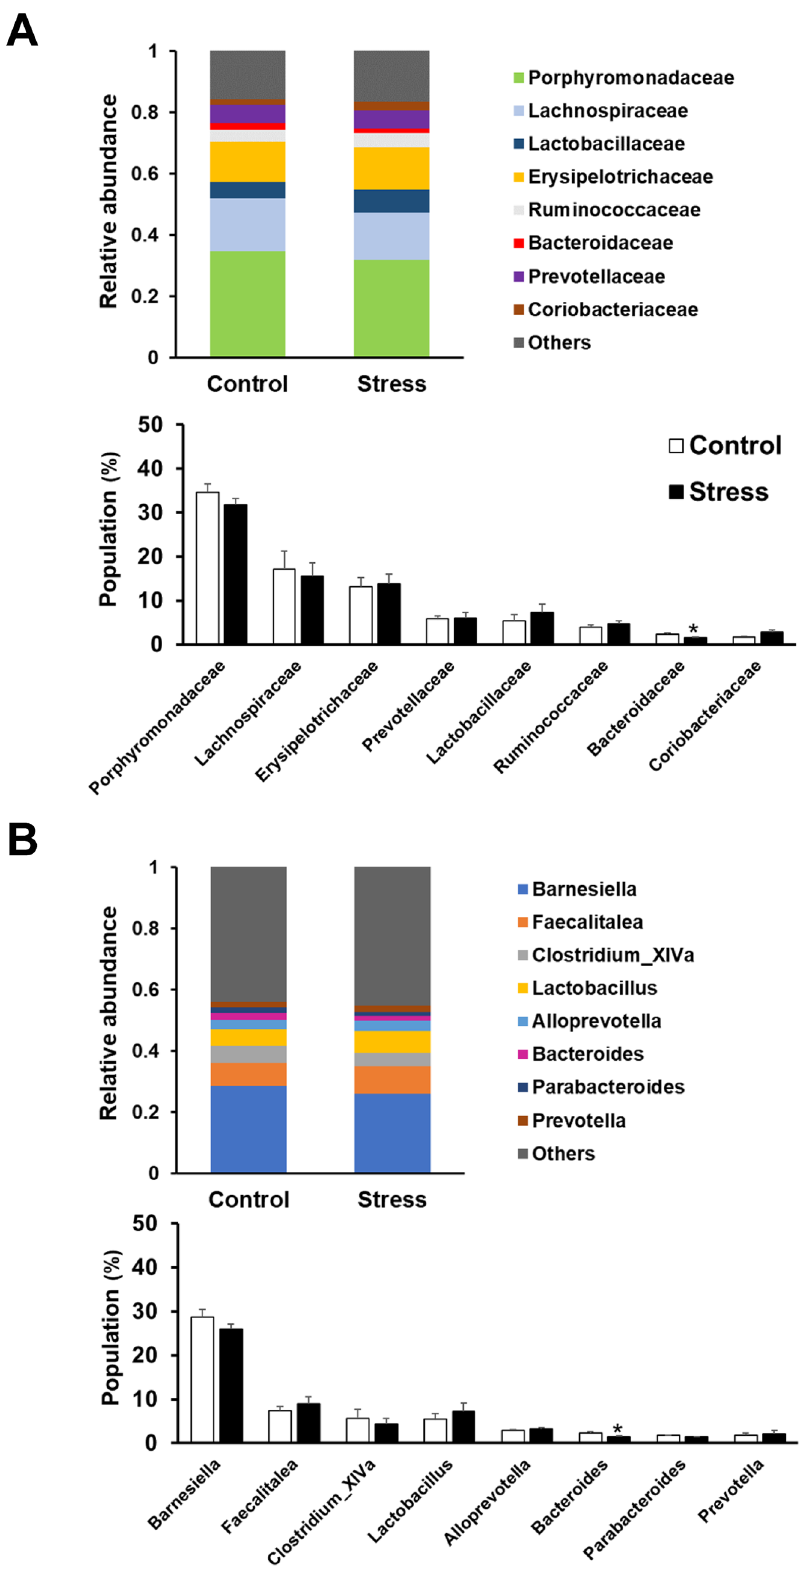
Figure 5. Composition of gut bacterium at the levels of family ( A ) and genus ( B ) in the control and juvenile SDS (stress) mice. Microbiome analysis of fecal samples for each bacterial genus was performed using next generation sequencing of bacterial 16S rDNA. The relative abundance (upper panel) and population (lower panel) of the top eight gut bacterium in control and juvenile SDS mice stool samples. Data are presented as the mean ± SEM (n = 8–10 mice per group). * p < 0.05 compared with the control